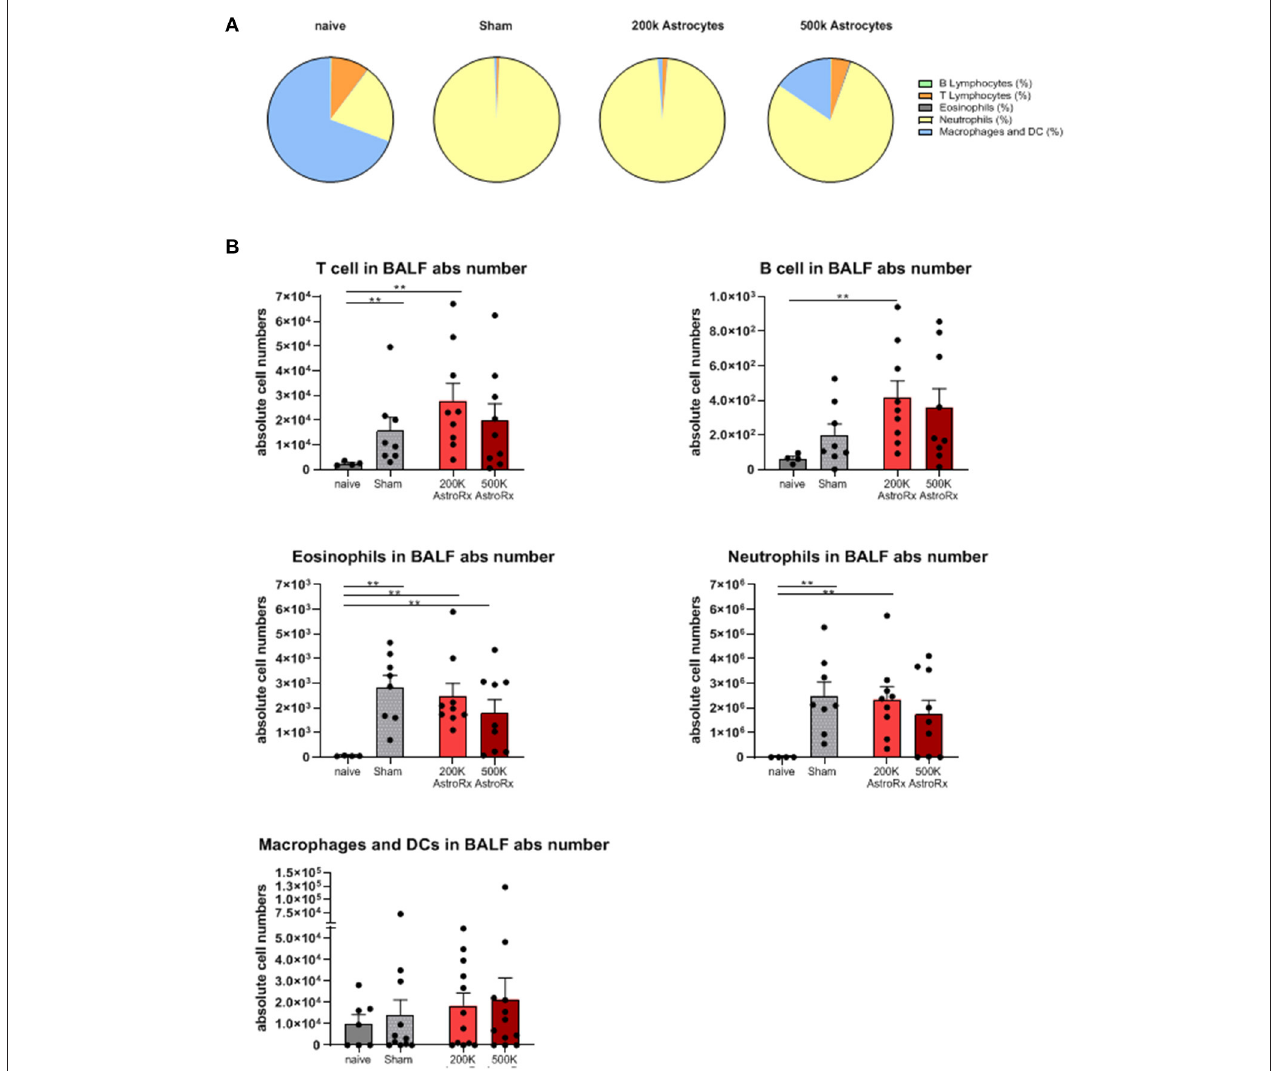
FIGURE 3 | Immune cells analyses of bronchoalveolar lavage. Bronchoalveolar lavage (BALF) was analyzed by flow cytometry for T cells, B cells, eosinophils, neutrophils, and macrophages/dendritic cells. (A) Proportions of each cell population by treatment. (B) An absolute number of each cell population in the BALF. The results are expressed as mean ± SEM. The Mann–Whitney comparison test. Naïve vs. sham: ** p = 0.0081, naïve vs. 200K astrocytes: ** p = 0.0028 (T cells, eosinophils, and neutrophils), ** p = 0.0056 (B cells), naïve vs. 500K astrocytes: ** p = 0.0056 (eosinophils), ** p <